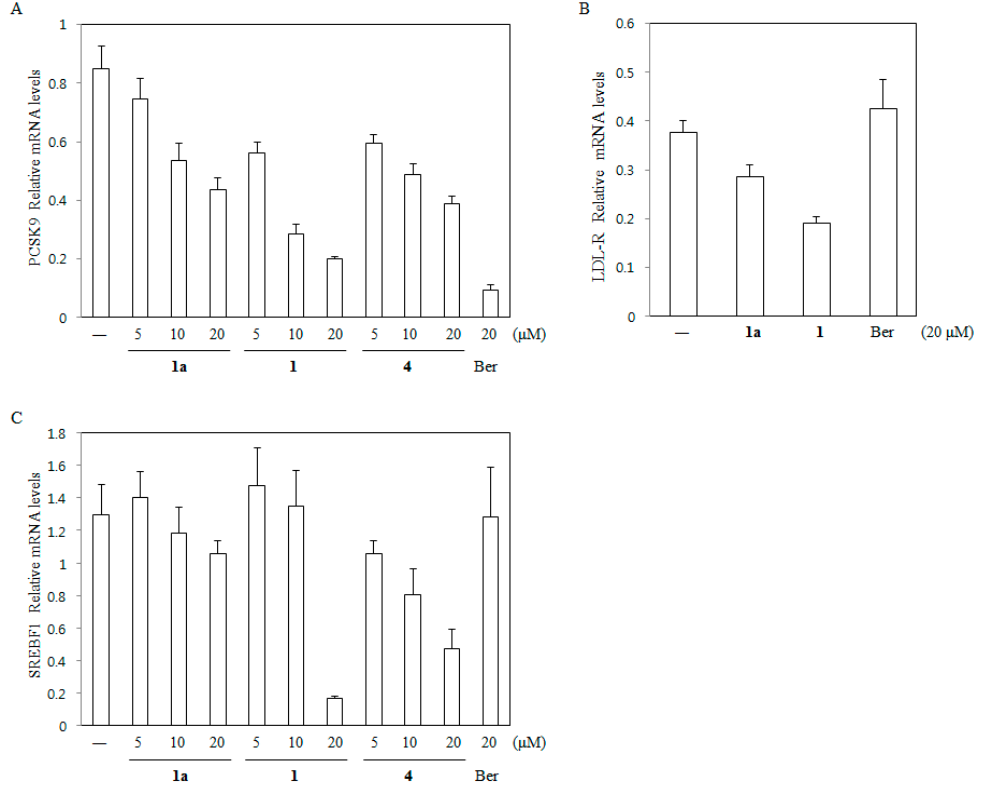
Figure 4. Expressions of PCSK9 ( A ) LDLR ( B ) and SREBF1 ( C ) were assayed by qRT-PCR in cells treated with compounds 1a , 1 , 4 and Ber (berberine) at a indicated concentrations.